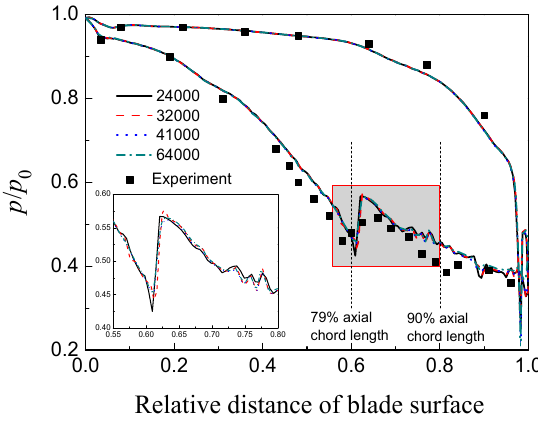
Figure 2. Comparison of pressure ratio and experimental value of the blade surface.